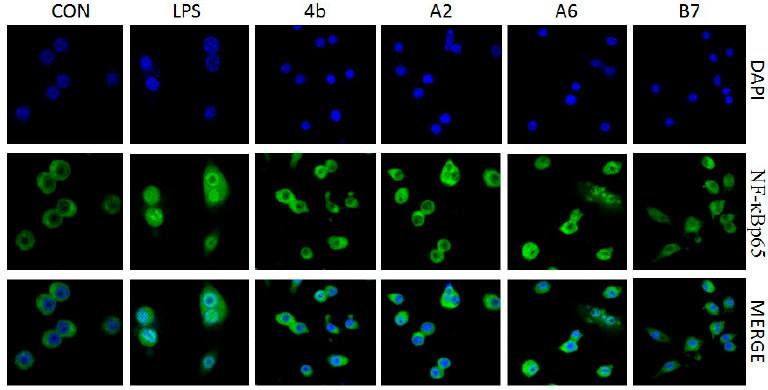
Figure 8. Immunofluorescence of NF- κ B p65 in RAW264.7 cells exposed to LPS (100 ng/mL) with or without compound 4b , A2 , A6 , and B7 (10 μ M).